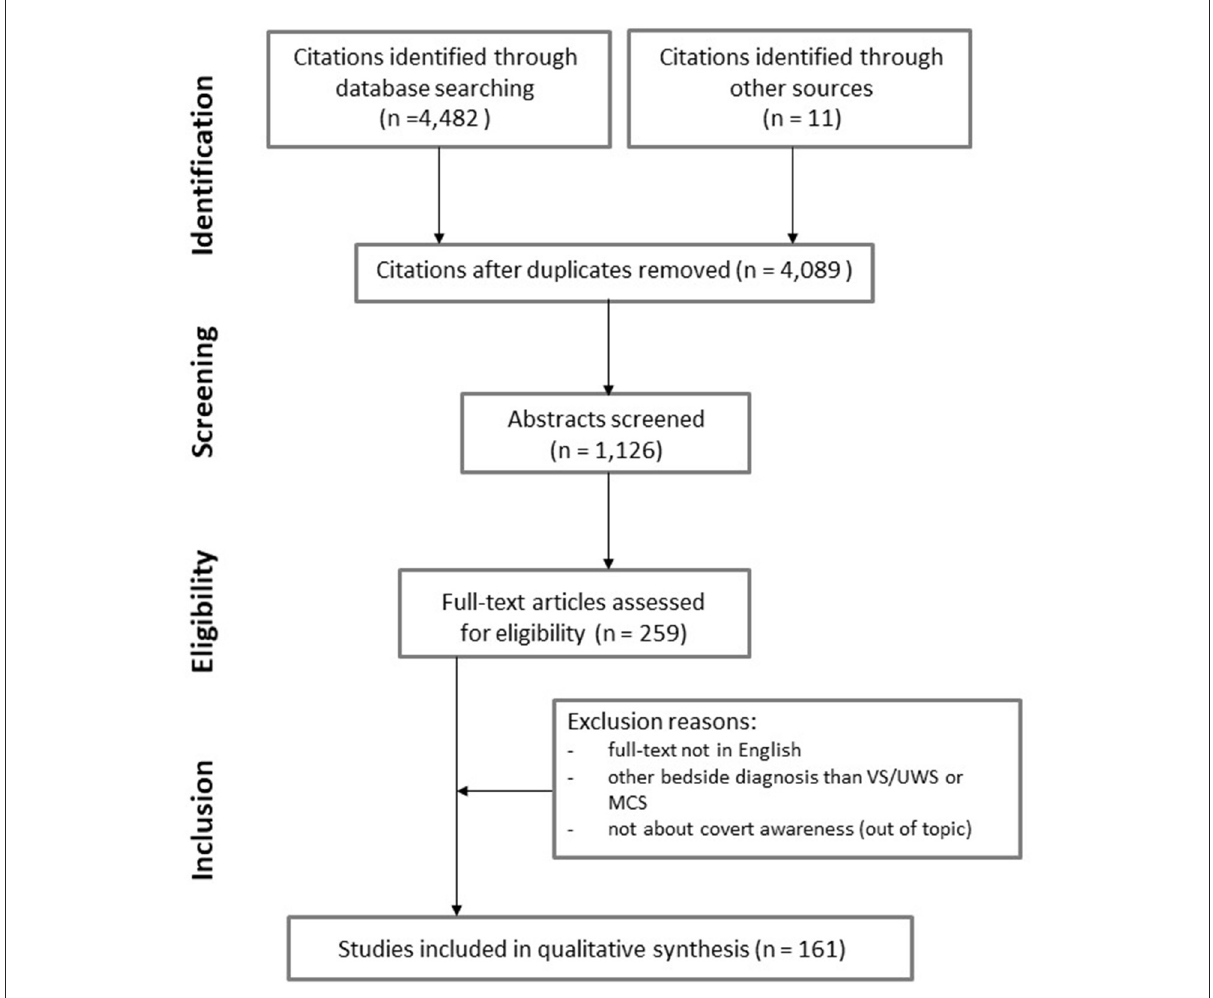
FIGURE1 PRISMA flow